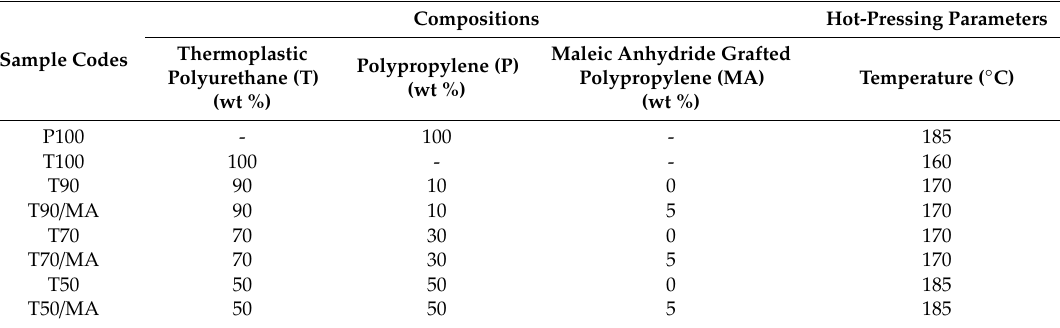
Figure 1. Sample preparation and recycling routes of thermoplasticpolyurethane and polypropylene (T/P) and T/P/maleic anhydride (MA) waste-blended materials. Table 1. Parameters of T/P and T/P/MA blends in the hot-pressing process.